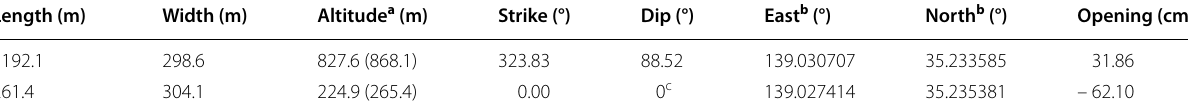
a Altitudes are height above sea level of the crack top edges, with ellipsoidal heights in parentheses b East and North coordinates are in WGS84 and refer to the upper left corner of cracks c